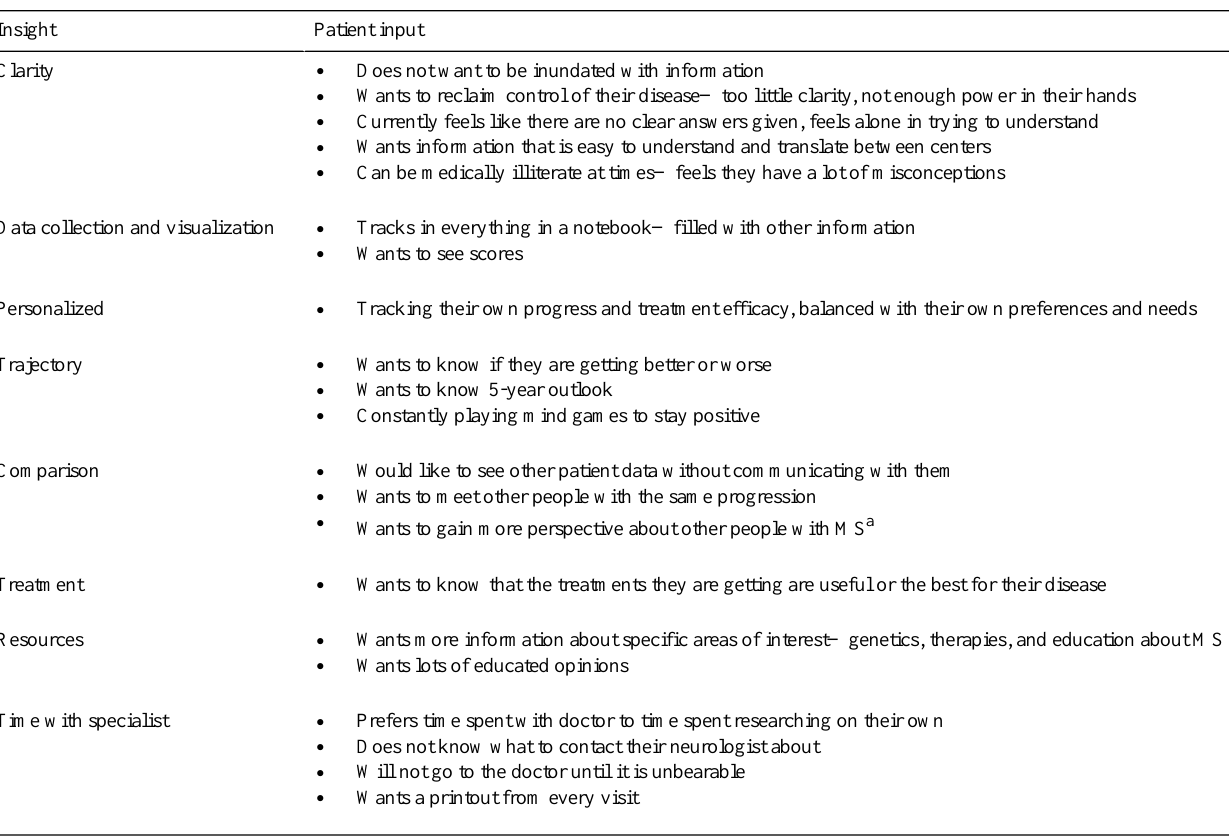
Table 1. Patient interview